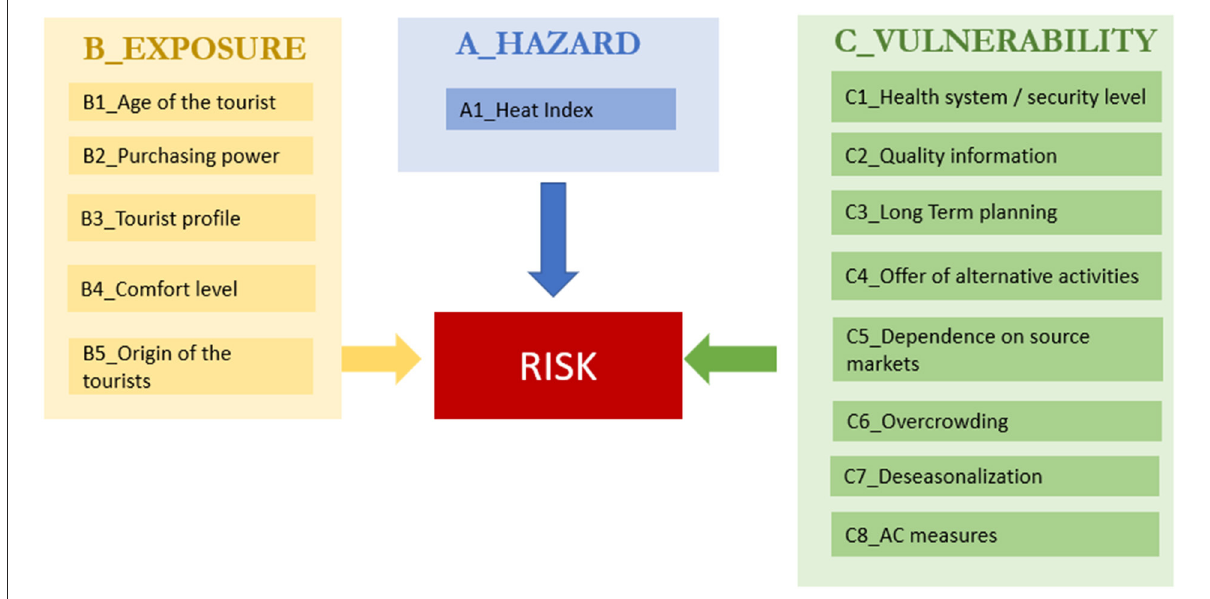
FIGURE4 Impact chain 1, corresponding to the “Risk of loss of attractiveness due to an increase in the heat stress”.